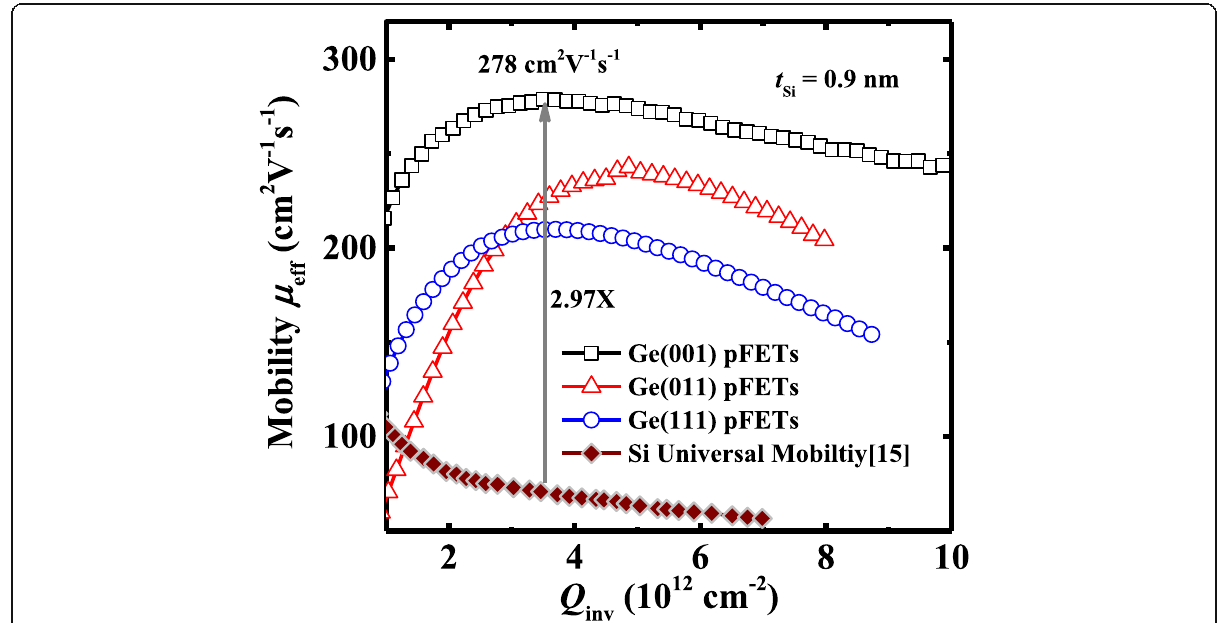
Fig. 6 Plot of μ eff versus Q inv for Ge pMOSFETs with 0.9 nm t Si on (001)-, (011)-, and (111)-oriented substrates. Ge(001) pMOSFETs achieve the 2.97 times enhancement in μ eff at a Q inv of 3.5 × 10 12 cm − 2 as compared to the Si universal mobility. The μ eff was extracted using a total resistance slope-based method [17]